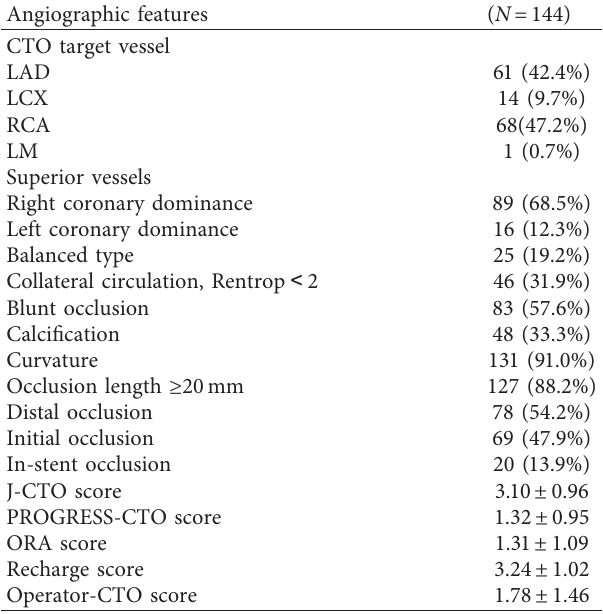
Table 4: Angiographic features of the study population. Angiographic